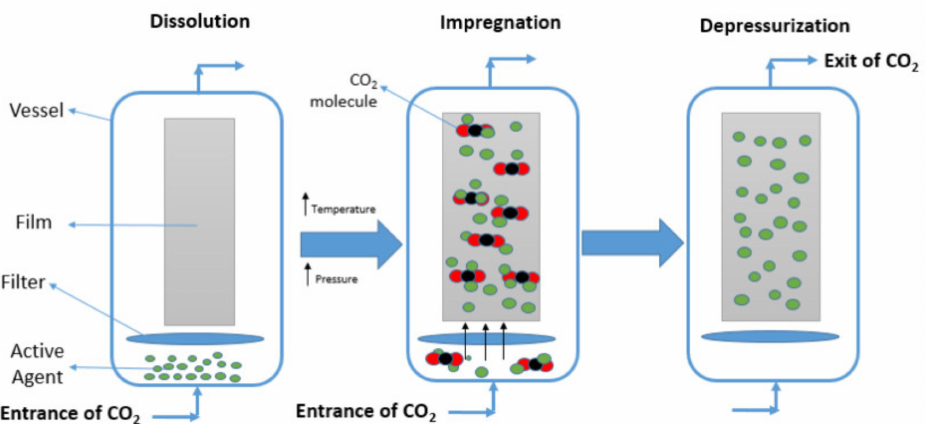
Figure 6. Schematic of the use of supercritical fluid carbon dioxide (CO 2 ) in the impregnation process during active film